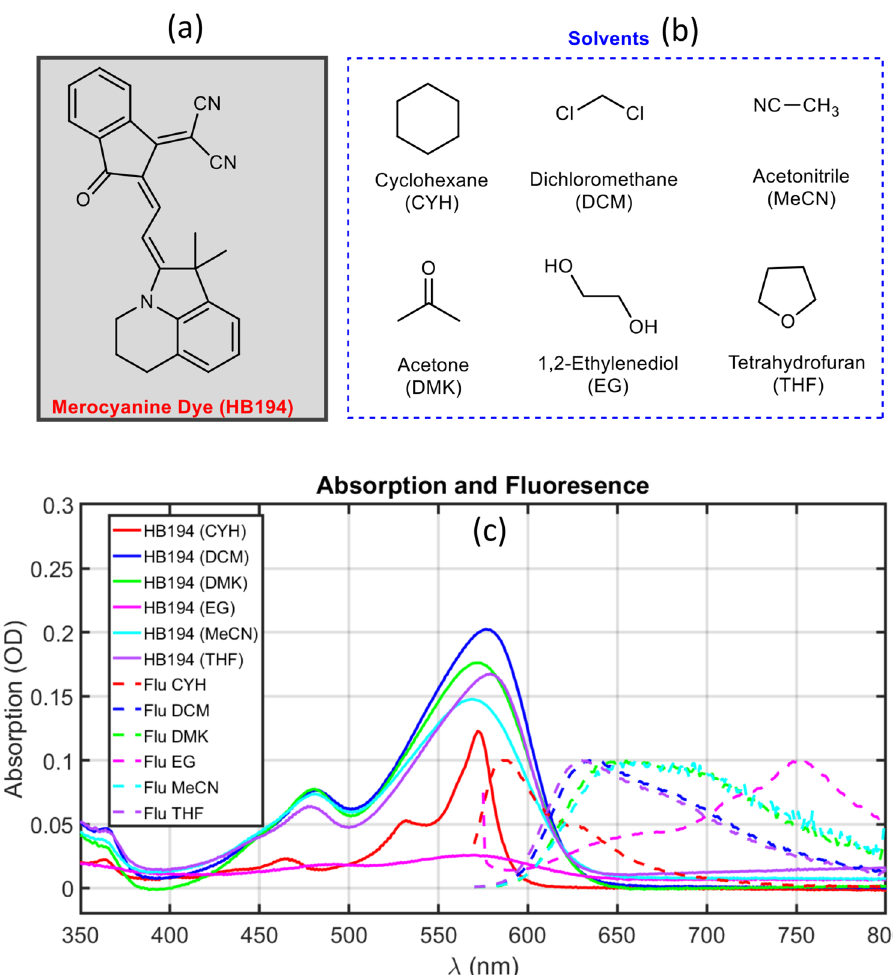
Figure 1. Solvatochromism in Merocyanine dye, HB194. ( a ) Molecular structure of Merocyanine dye (HB194); ( b ) solvents used in this study to understand the solvatochromic behaviour of the dye; ( c ) absorption (solid lines) and fluorescence spectra (dashed lines) of HB194 in different solvents. The absorption spectra of HB194 solutions are shown in optical density (OD) unit, which are used for transient absorption studies. The fluorescence spectra are obtained after subjecting the sample solutions to excitation at 530 nm and then the spectra are normalized for comparison. The solvatochromic behaviour can clearly be seen from fluorescence spectra with an anomalously red-shifted spectrum in EG. Based on these steady state measurements, HB194 solutions are categorized into four different groups: HB194 (CYH), HB194 (THF, DCM), HB194 (DMK, MeCN) and HB194